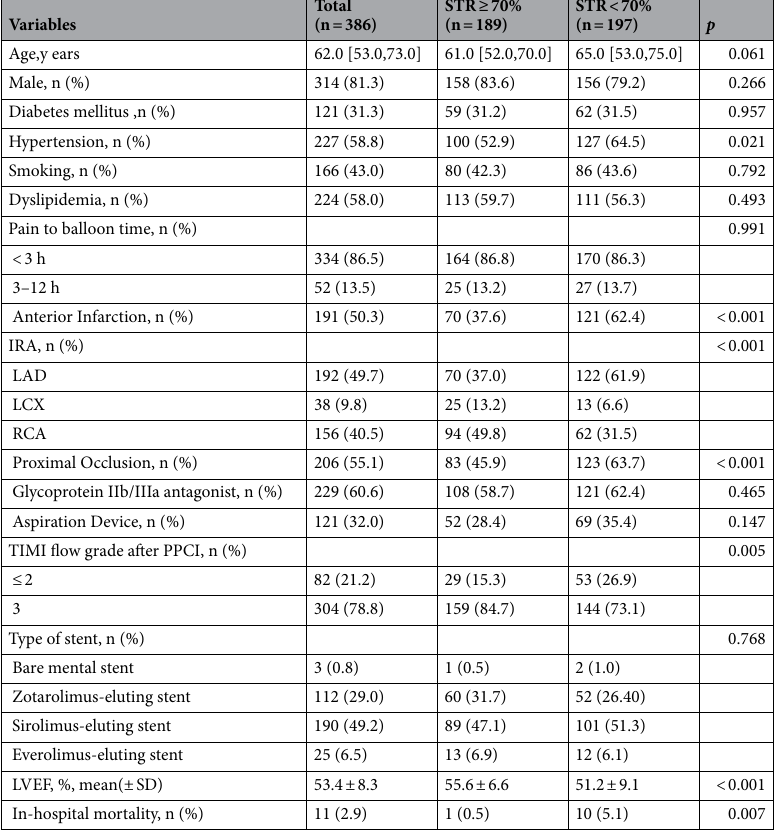
Table 1. Patient demographics and clinical characteristics. PPCI primary percutaneous coronary intervention, LVEF ejection fraction, TIMI thrombolysis in myocardial infarction.